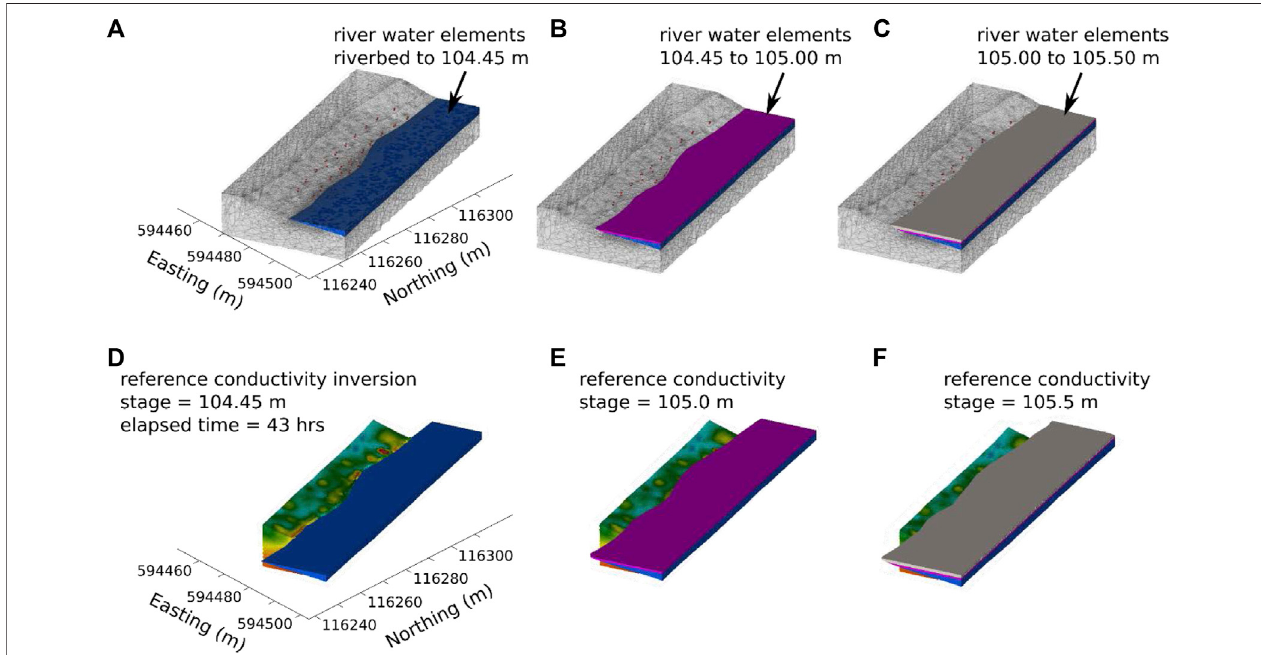
FIGURE4| Explanationofstageeffectcomputations. (A – C) Computationalmeshesforthreedifferentriverstages.Eachmeshisidenticalexceptfortheriverwater elements. River water elements are added to mesh A to produce mesh B, and to mesh B to produce mesh (C) . (D) reference conductivity σ ref derived by inverting the ERT data D ref collected at 43 h ( Figure 2 ) when the stage was 104.45 m in elevation. (E) Reference conductivity and stage at 105.0 m, used for computing D l at l = 105.0 m. (F) Reference conductivity and stage at 105.5 m, used for computing D l at l = 105.5 m.